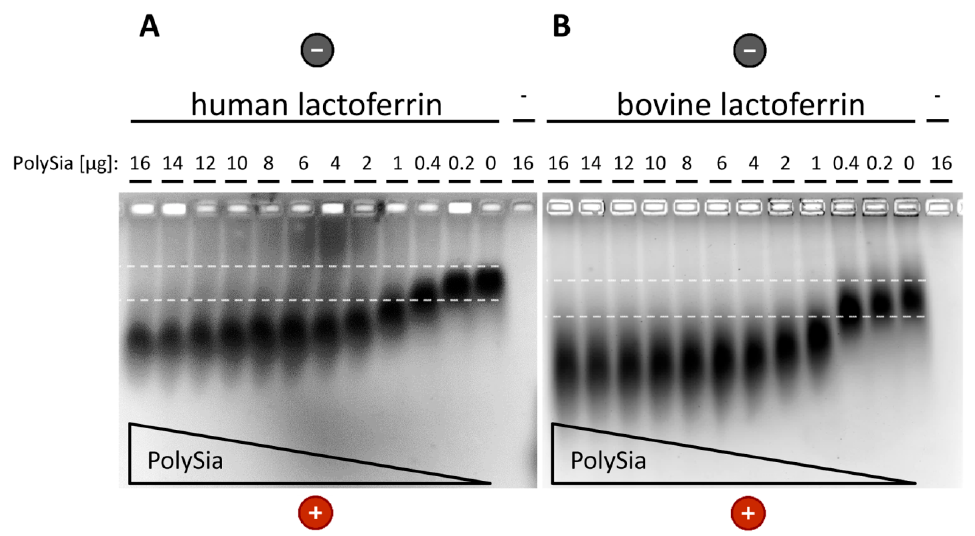
Figure 3. PolySia interacting comparably with ( a ) human and ( b ) bovine lactoferrin. The interaction of polySia with human and bovine lactoferrin was analyzed using a native agarose gel system. The lactoferrin (8 µg; molecular weight of lactoferrin: bovine, 87 kDa; human, 82 kDa) was incubated with different amounts of polySia and subsequently separated through electrophoresis. Proteins were stained using Coomassie blue.